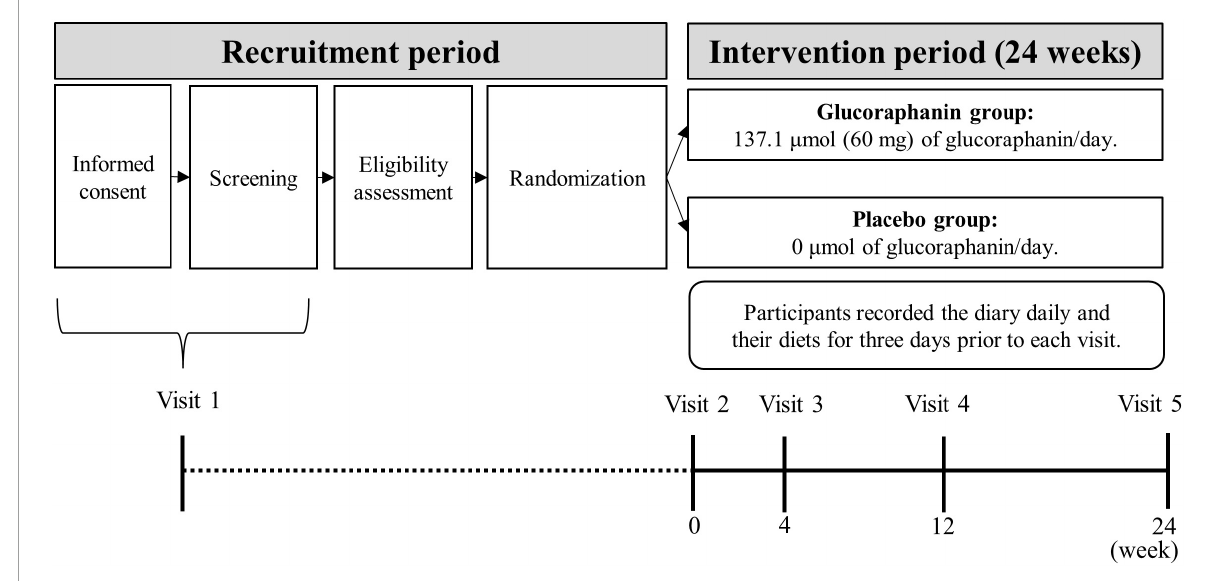
FIGURE1 Outline of the trial design 1 . 1 Visit dates: Visit 1; between April 22nd and July 3rd, Visit 2; between May 17th and July 10th; Visit 3: between June 14th and August 7th; Visit 4: between August 9th and October 2nd; Visit 5: between November 1st and December 25th. Each visit was conducted in